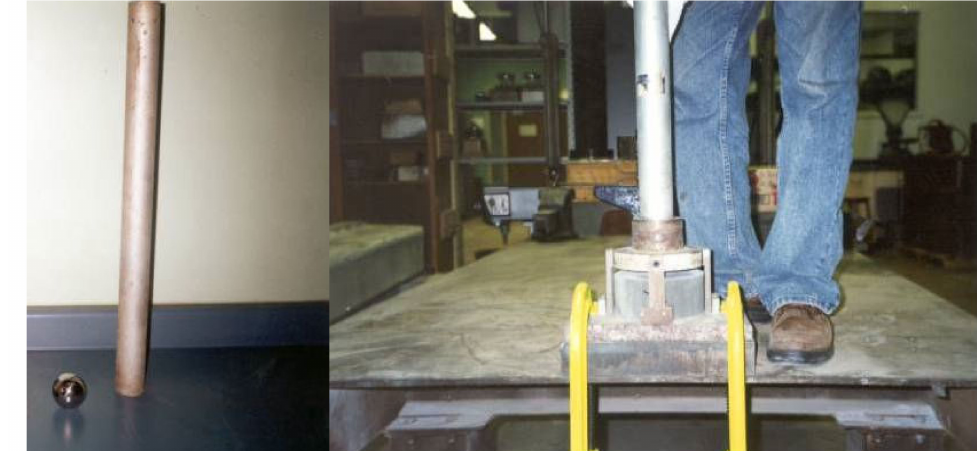
Figure 5. Impact test apparatus and testing of mortar composite using cylinder